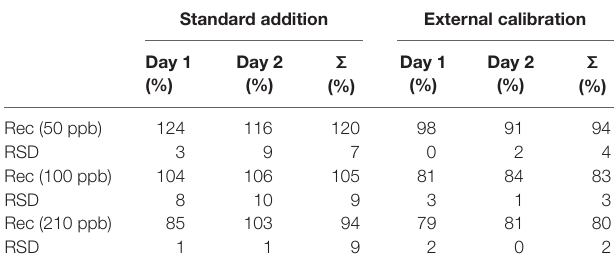
TaBle 2 | Recovery (Rec) results by standard addition and external calibration methods ( n = 3). standard